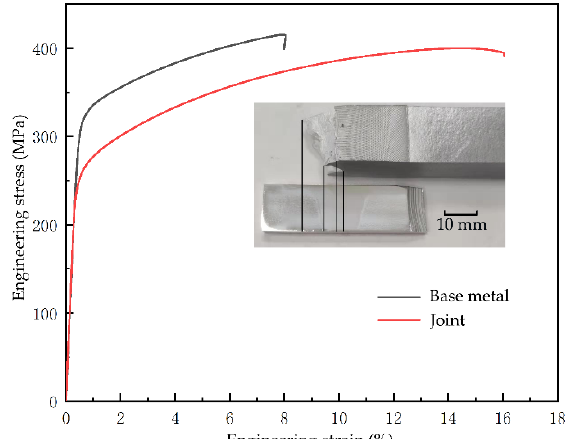
Figure 5. The curve of engineering stress–engineering strain, and the position of fracture. Table 2. Tensile properties of base metal and the joint.